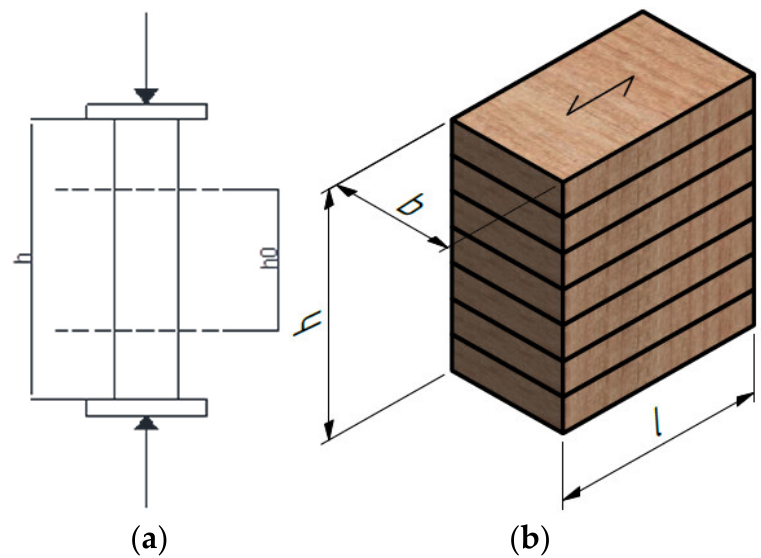
Figure 3. Test setup: ( a ) Load and gauge position; ( b ) specimen dimensions.